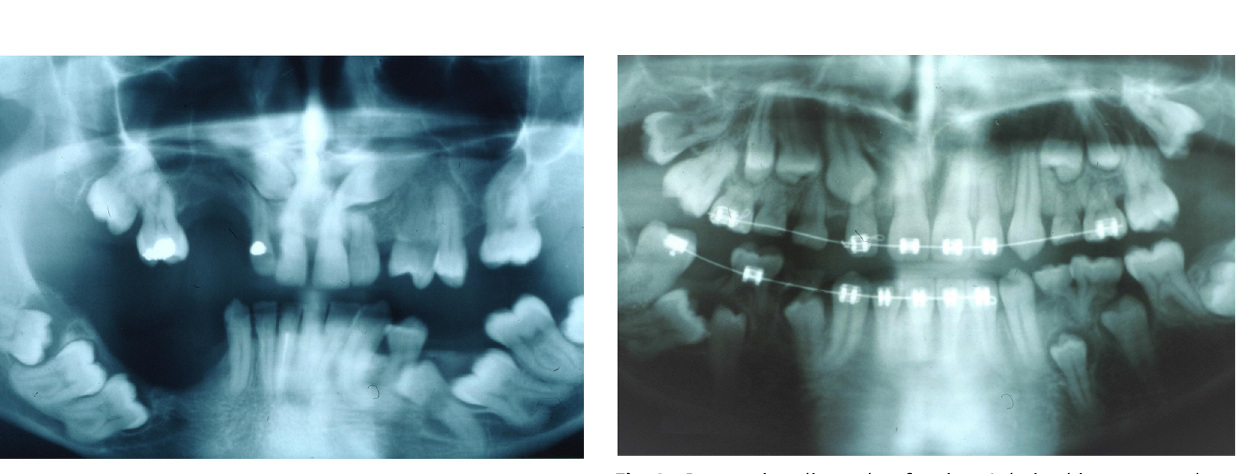
Fig. 1. Panoramic radiography of patient A ’ s father. He has not had any orthodontic treatment.